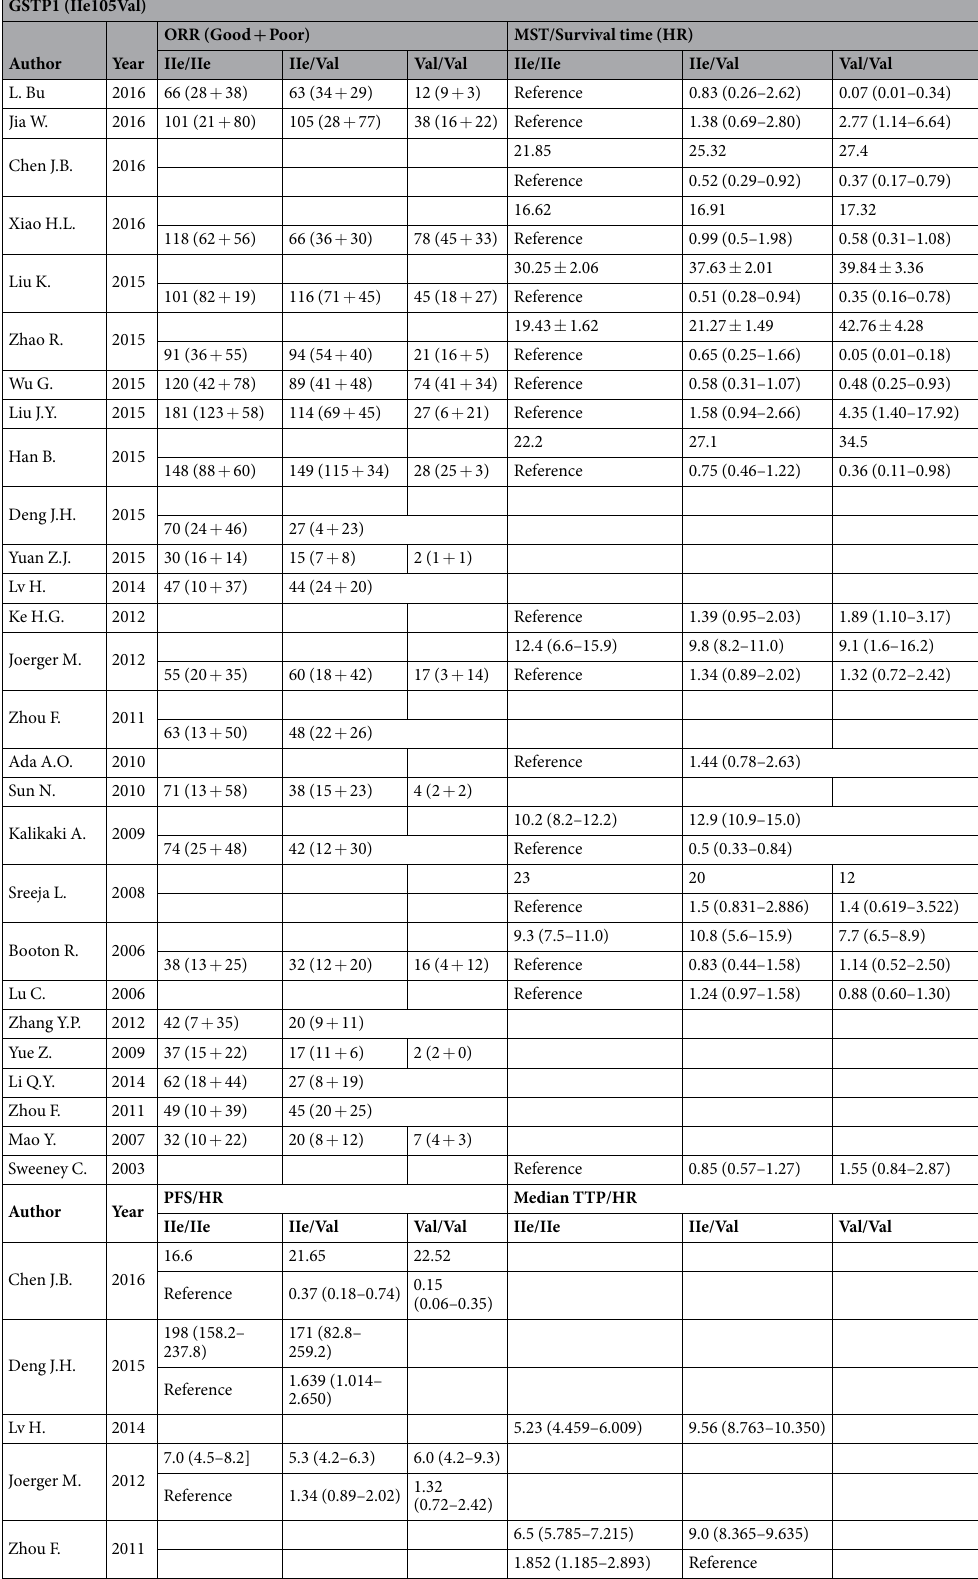
Table 2. Association between the GSTP1 IIe105Val polymorphism and objective response rate, median survival time, median time to progression and median progression-free survival of platinum-based chemotherapy